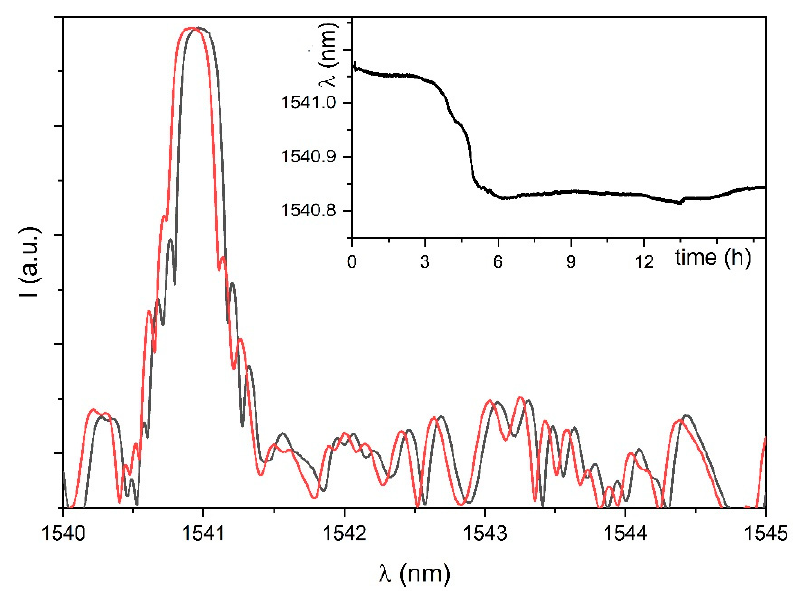
Figure 4. Spectra of sample FBG-PVC before (black) and after (red) the film forming process. In the inset: the time history of λ B during the film forming process.